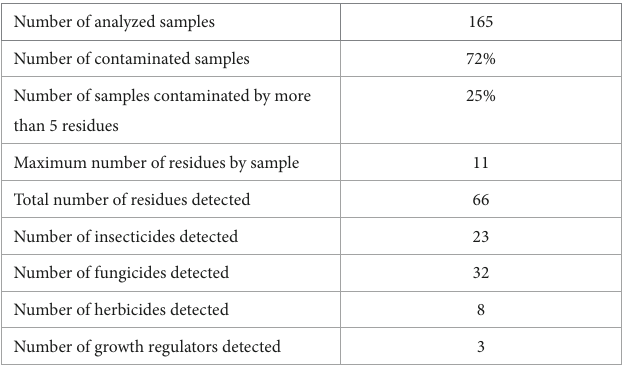
TABLE 1 Results of chemical analysis of 165 pollen samples collected in five French regions (Vidau,